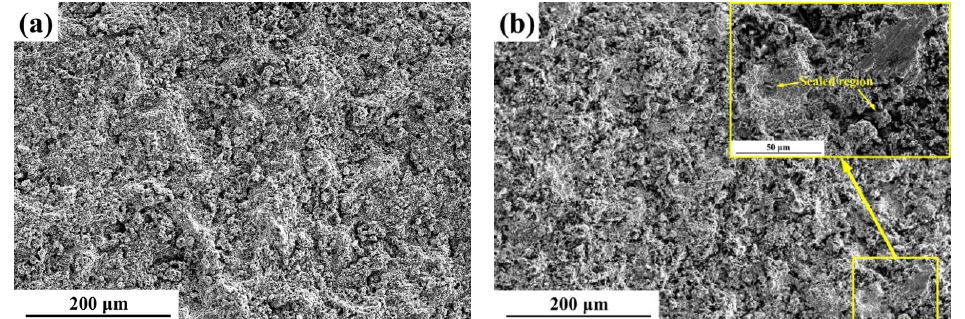
Figure 2. SEM images of the surface morphologies of ( a ) unsealed and ( b ) sealed nanostructured WC-CoCr coatings.